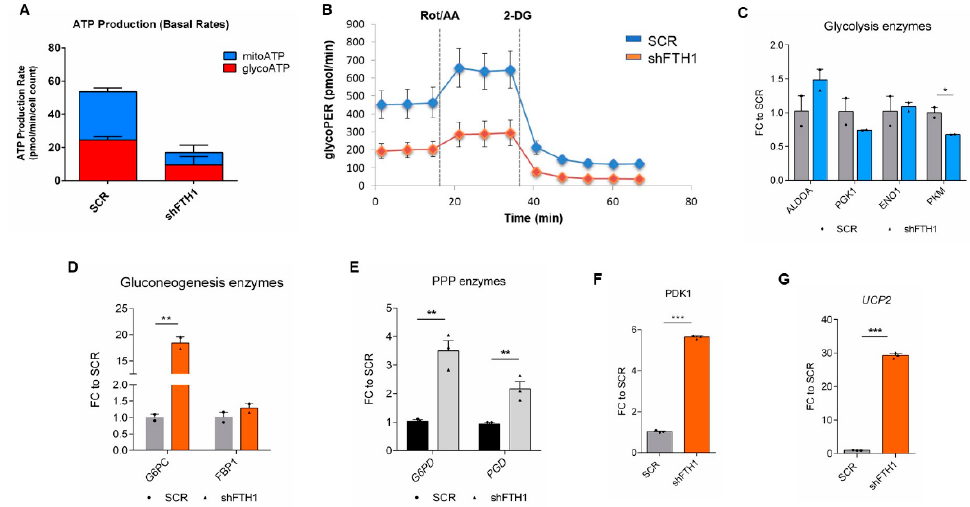
Figure 5. Metabolic rearrangement in FTH1-KD hESCs. ( A ) Quantification of total cellular ATP production (from glycolysis and mitochondrial oxidative phosphorylation) rate using a Seahorse XF analyzer. ATP production was calculated by measuring the oxygen consumption and acidification rate. Each sample (SCR and shFTH1-hESCs) was measured in at least three biological replicates. Seahorse analysis shows a lower ATP production (from both sources) in FTH1-KD cells compared to SCR control; ( B ) Glycolytic rate measurements in SCR and FTH1-silenced cells calculated by subtracting extracellular acidification rate (ECAR). As shown, FTH1-KD hESCs do not undergo metabolic switch. Since mitochondrial acidification is blocked, the approach measures glycolytic-ECAR only correlating to extracellular lactate accumulation. Glycolytic rate was reduced in FTH1-silenced hESCs; ( C ) qRT-PCR analysis for glycolytic enzymes ( ALDOA2 , PGK1 , ENO1 , and PKM ) mRNA expression; ( D ) Expression of G6PC and FBP1 gluconeogenesis genes in SCR and shFTH1-hESCs measured by qRT-PCR analysis; ( E ) Pentose phosphate pathway (PPP) genes G6PD and PGD were significantly up-regulated shFTH1 cells with respect to SCR control cells; ( F , G ) The PDK1 gene, responsible for inactivation of pyruvate dehydrogenase ( F ) and the gene UCP2 ( G ), which uncouples OXPHOS from ATP synthesis, both resulted in significantly up-regulated in FTH1-KD cells compared to SCR cells. For all qRT-PCR graphs, results were normalized to measurements in SCR cells ( n = 3); * p ≤ 0.05; ** p ≤ 0.01, *** p ≤ 0.001, t- test compared to SCR. Small dots refer to SCR replicates, while triangles refer to shFTH1 triplicates. 4. Discussion Pluripotent stem cells (PSCs), including ESCs and iPSCs, possess unique and extraordinary self-renewal capabilities, while maintaining their pluripotency [61]. In addition to these properties, PSCs also have the ability to give rise to almost any cell type, both in vivo and in vitro. On the basis of these key features, PSCs technology holds enormous potential in many fields of biomedical research, including drug screening, development and repurposing [62–65], disease modelling [66–70], cell therapy [71], aging [72], and regenerative medicine [73]. Although significant progress has been made, many hurdles still need to be overcome to push PSCs technology towards the road to clinical practice. Apart from immunogenicity and genomic instability, undoubtedly representing the two major challenges, the successful differentiation and functional maturation of PSC derivatives must faithfully recapitulate all aspects of somatic cells and tissues, including the metabolic function. For instance, little is known about the role of ferritin heavy chain (FTH1), the major ferroxidase protein, in human ESCs homeostasis. Ferritin is composed of 24 heavy and light chains, whose core is able to sequester up to 4500 iron atoms [74]. Ferritin heavy chain, in particular, is responsible for the oxidation of ferrous iron [Fe(II)] to less reactive ferric iron [Fe(III)] [75]. Even though there is a wide literature suggesting that FTH1 is a major player in protecting cells against oxidative stress [76], so far, its role in embryonic stem cells has not been fully elucidated. As mentioned earlier in this work, ROS play an important role as second messengers in embryo development [77,78], and